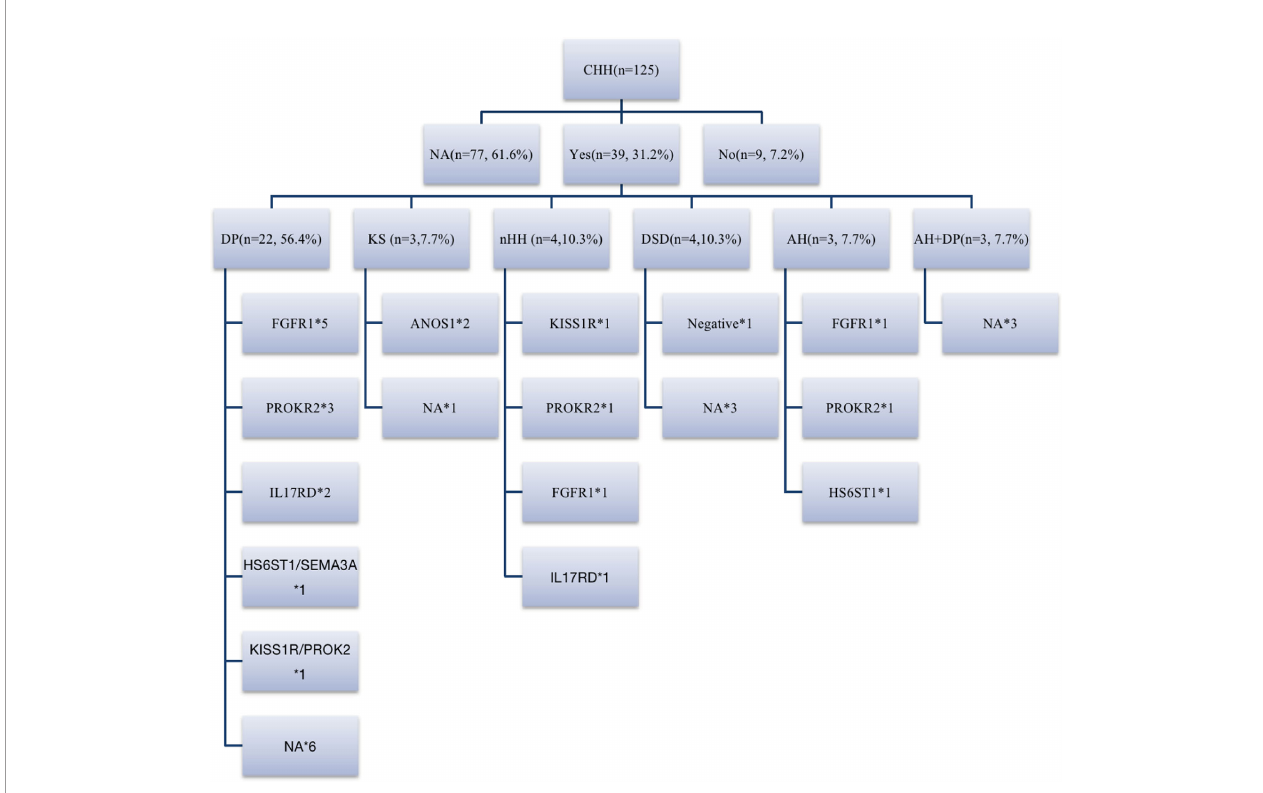
FIGURE 5 | Family history and genes of patients with CHH. 31.2% (39/125) of patients could be traced back to positive family history, including DP, CHH, DSD, abnormal smell, abnormal smell combined with DP family history. 18% (7/39) of patients had KS/nHH family history, and more than half of patients had DP family history, FGFR1 , IL17RD , HS6ST1 and SEMA3A are shared genes of CHH and DP reported before, while in our cohort, we believe that PROK2/PROKR2 and KISS1R are also potential shared genes. DP, delayed puberty; DSD, disorders of sex development; AH, anosmia or hyposmia. *represents the number of cases with the same gene